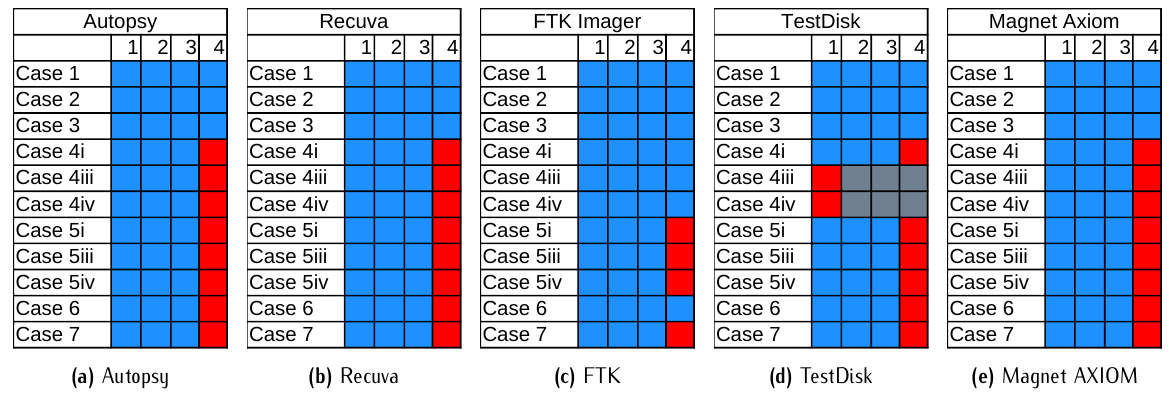
Figure 11. Test results on NTFS test cases for each DFR tool. Rows represent test cases whereas columns represent NIST core features. Blue is passing, red is failing, gray is not